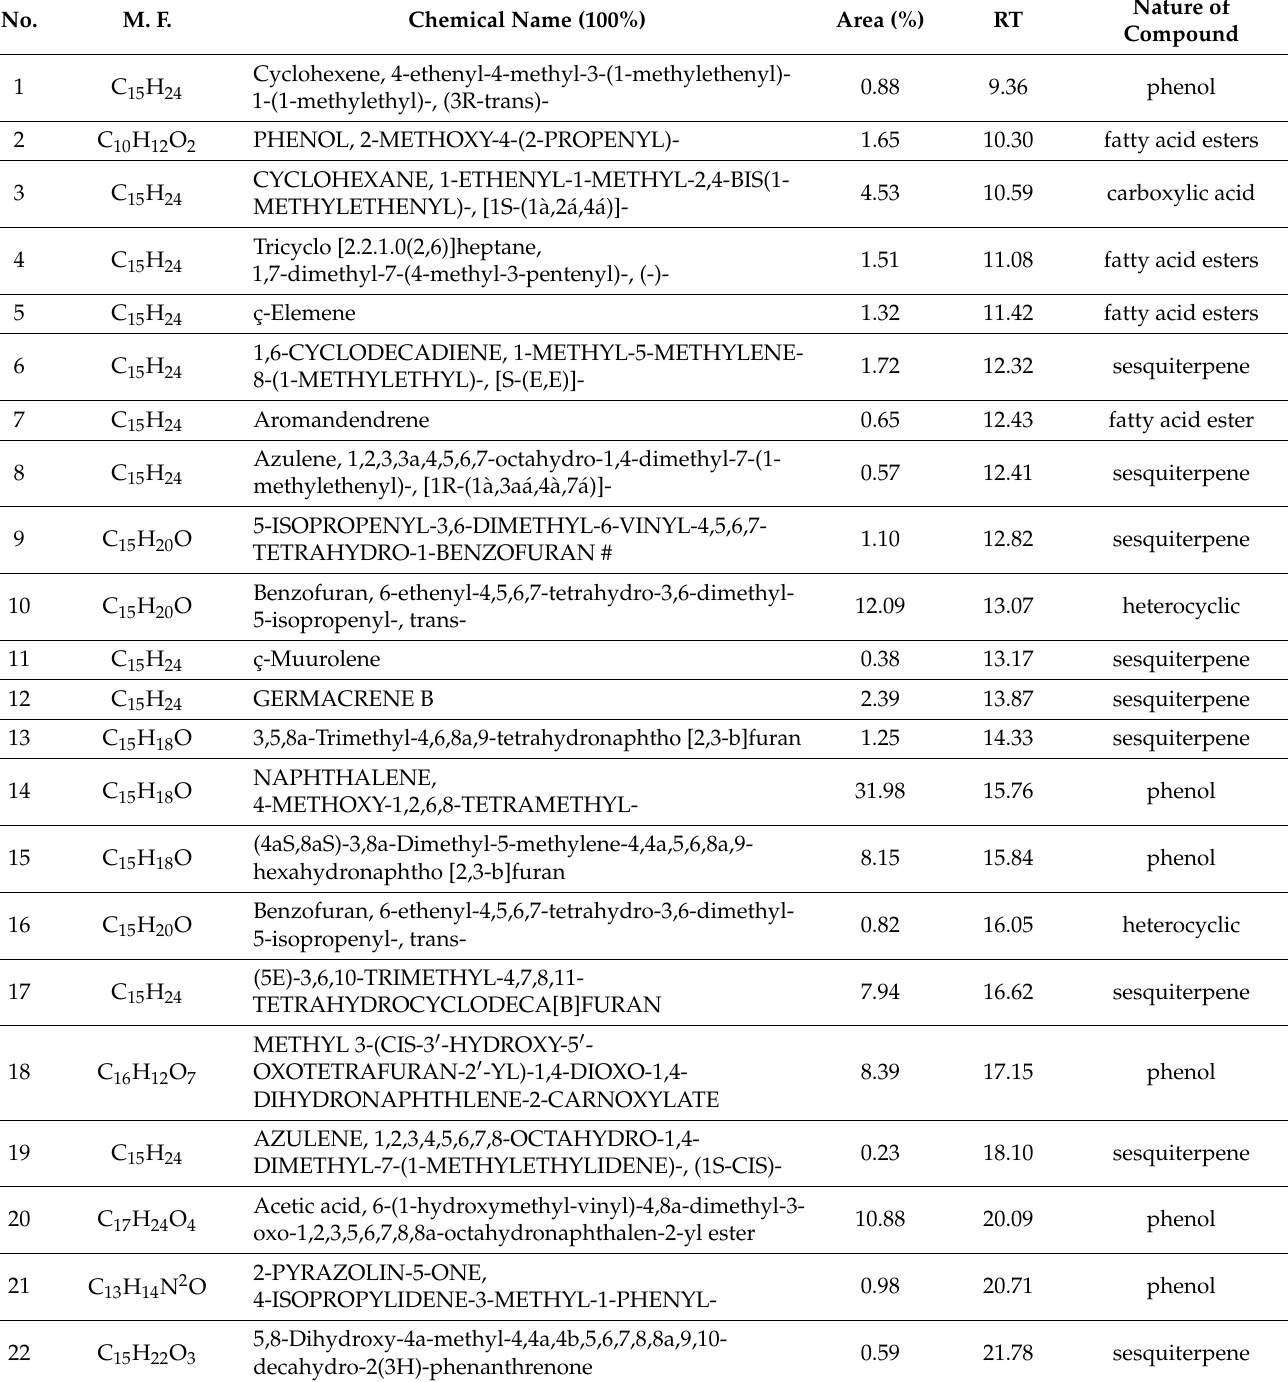
Table 10. The major chemical constituents of Commiphora molmol hexane